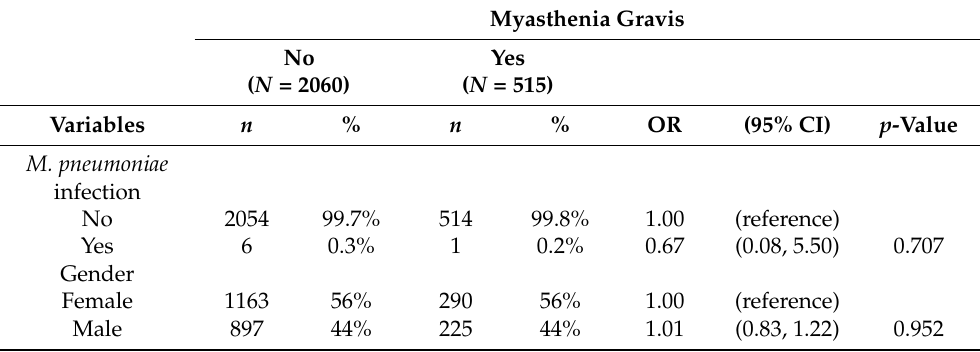
Table 3. Sensitivity analysis with case control study